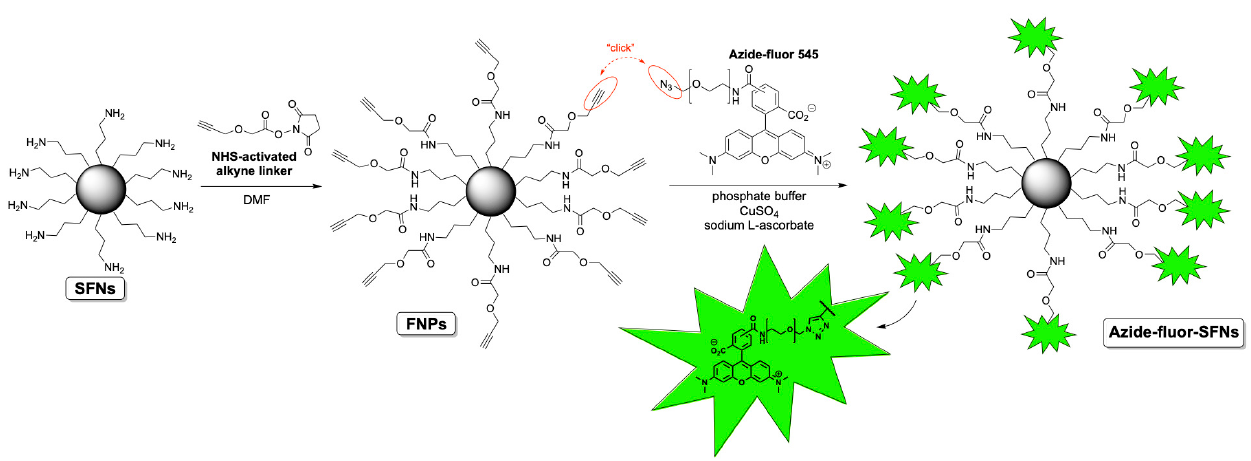
Figure 1. Scheme of SFNs’ bioconjugation with Azide-fluor 545.